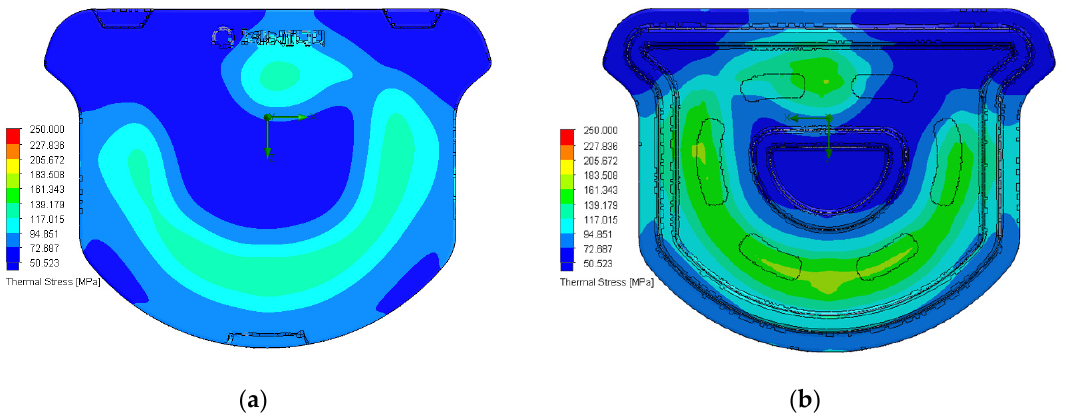
Figure 15. ( a ) Thermal stress distribution on the ( a ) surface and ( b ) bottom of the CA#3 stone grill plate.